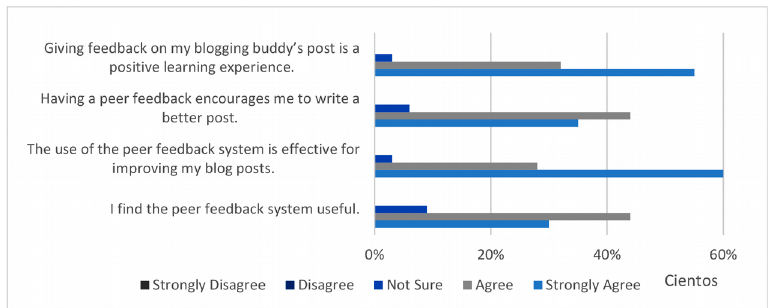
Figure 3. Students’ perception on the use of peer feedback in